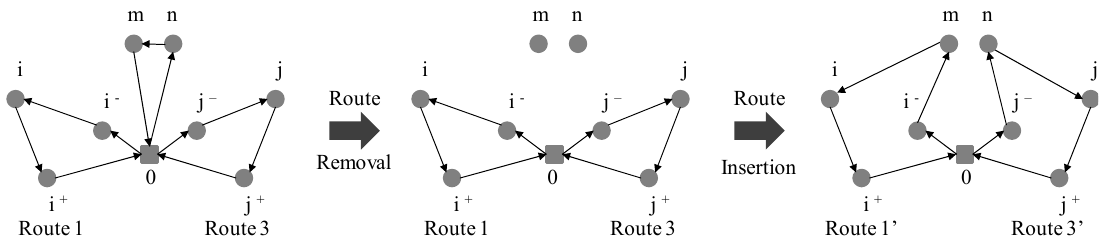
Figure 3. Route Removal and Reinsertion of Customers.